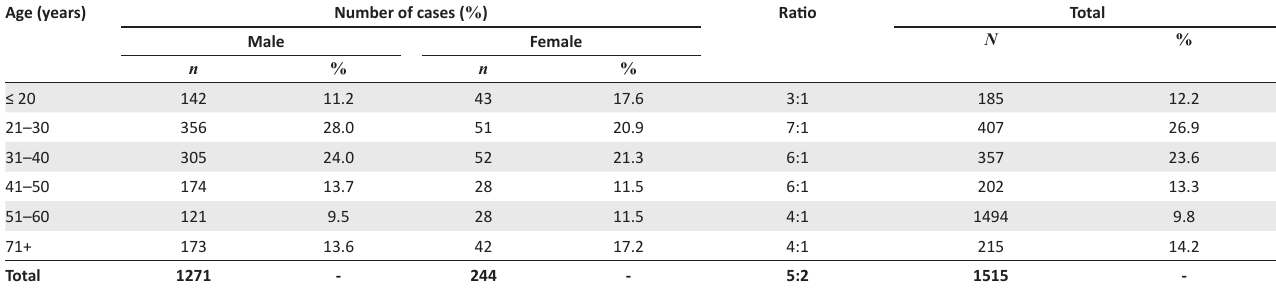
TABLE 1 : Demographic characteristics of suicides